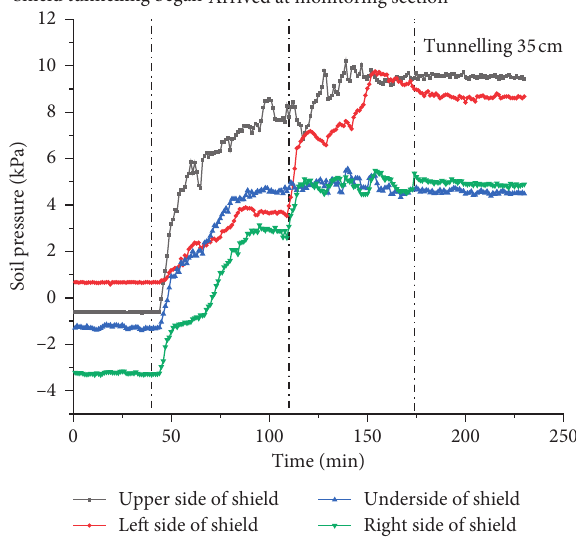
Figure 15: Time-history curve of earth pressure around the shield